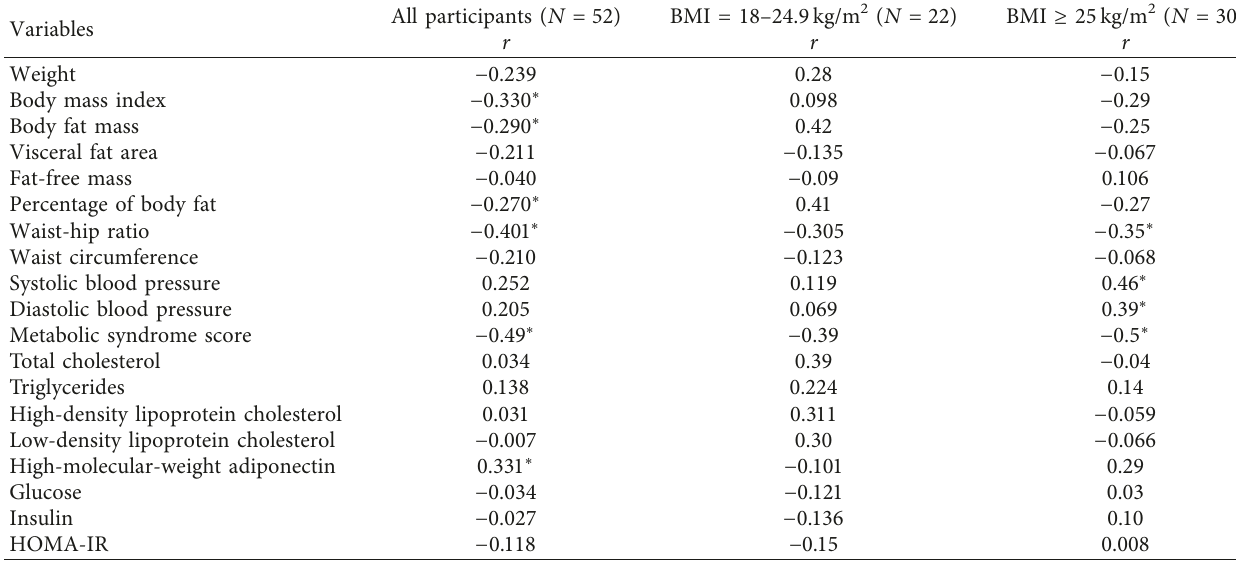
Table 5: Correlations between the daily steps count and anthropometric measurements and blood pressure after intervention ( N � 52).